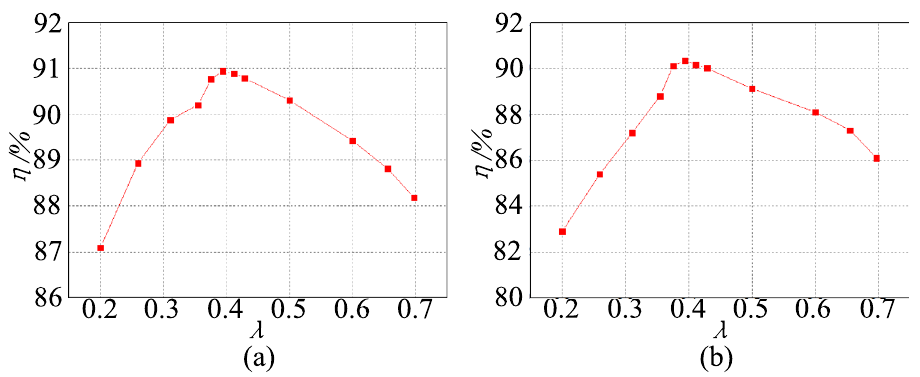
Figure 26. The efficiency curves of (cid:31) , ( a ) step-up mode, ( b ) step-down mode.